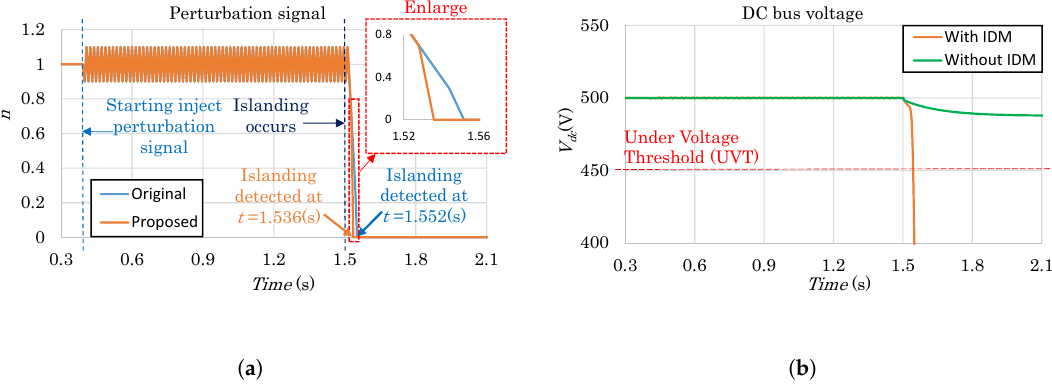
Figure 17. Result in case of multi-PV operation, 40 kW PV, hardest islanding condition (case 5): ( a ) Perturbation signal and ( b ) DC bus voltage (with and without IDM).